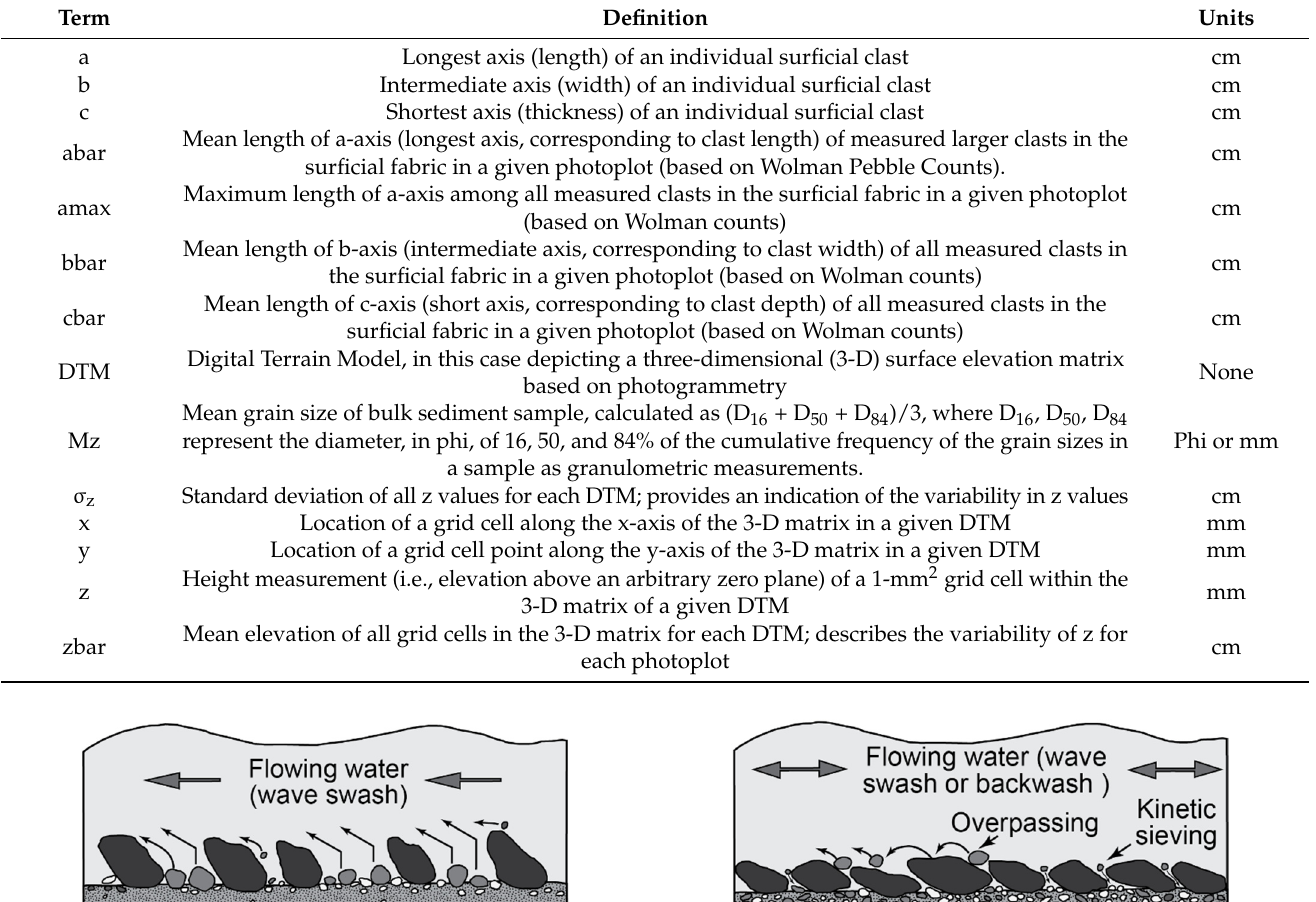
Table 1. Definitions for terms and acronyms used in this paper.